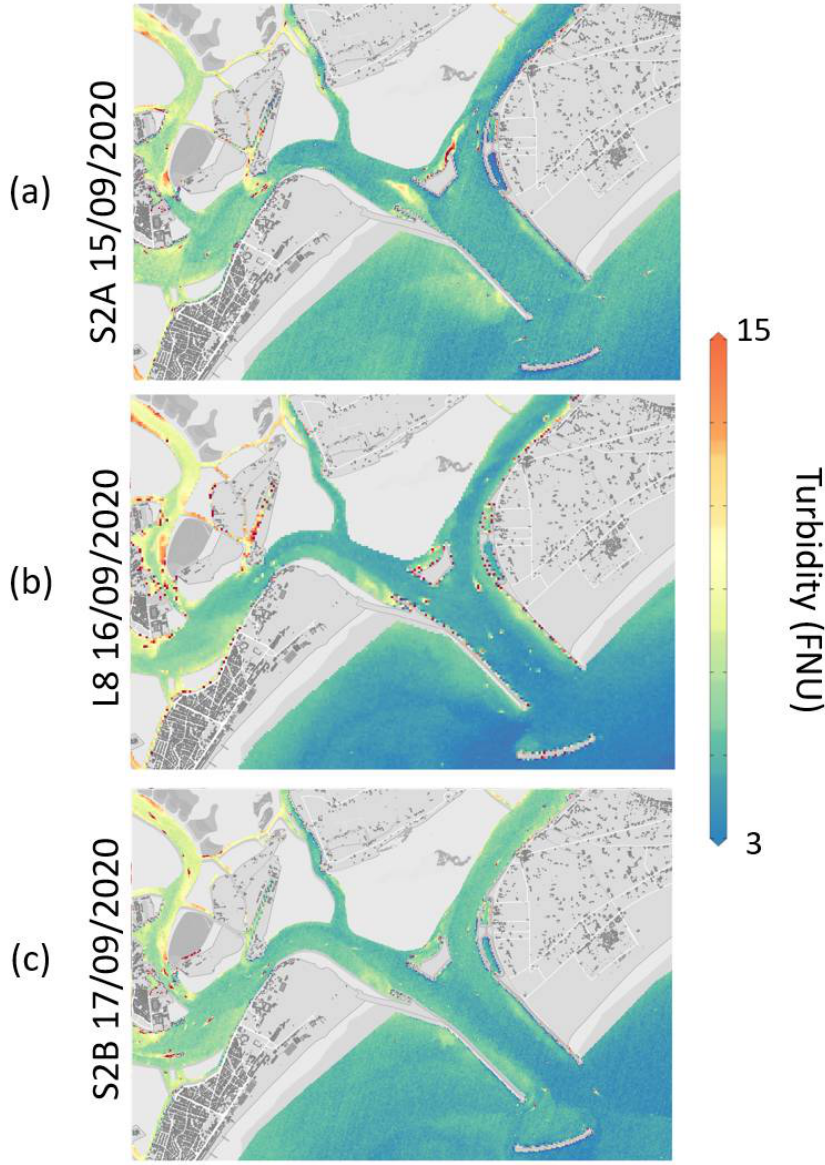
Figure 11. Satellite-derived turbidity maps of the study area for the investigated period: panel ( a )